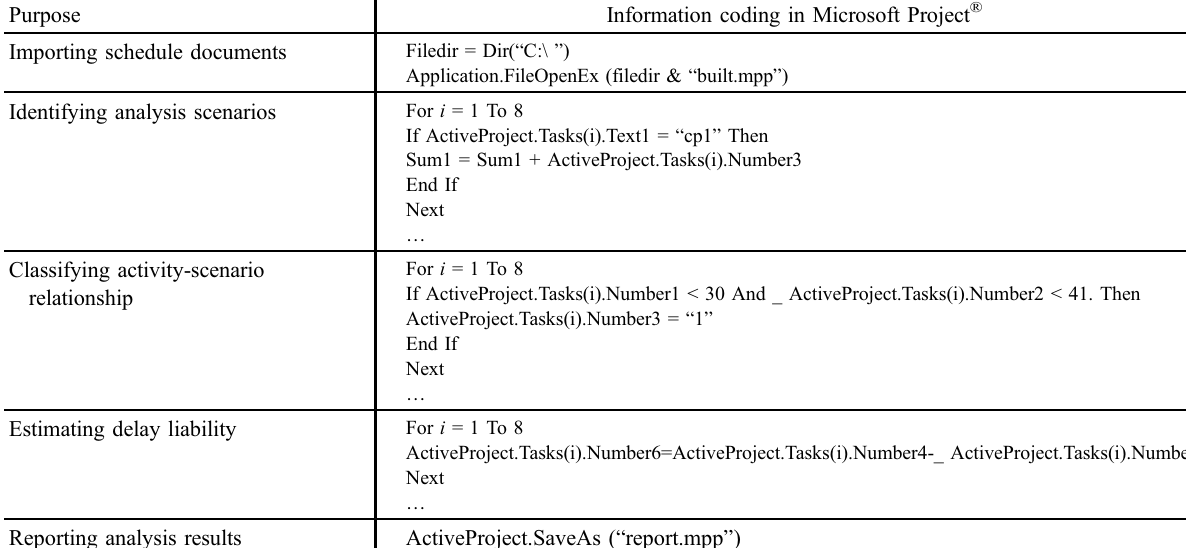
Table 3. Example codes in this study